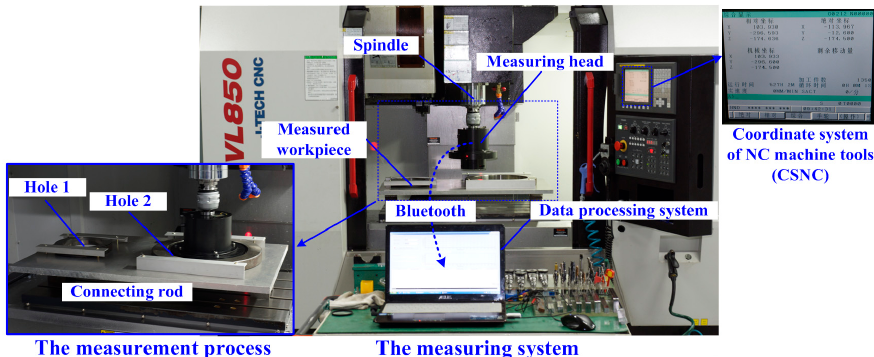
Figure 10. The in-situ measurement system. Table 2. The critical parameters of the measured connecting rod. Inner Diameter of Inner Diameter of Smaller Hole Bigger Hole